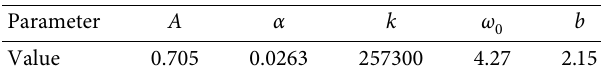
Table 3: The values of each parameter of the coherence function